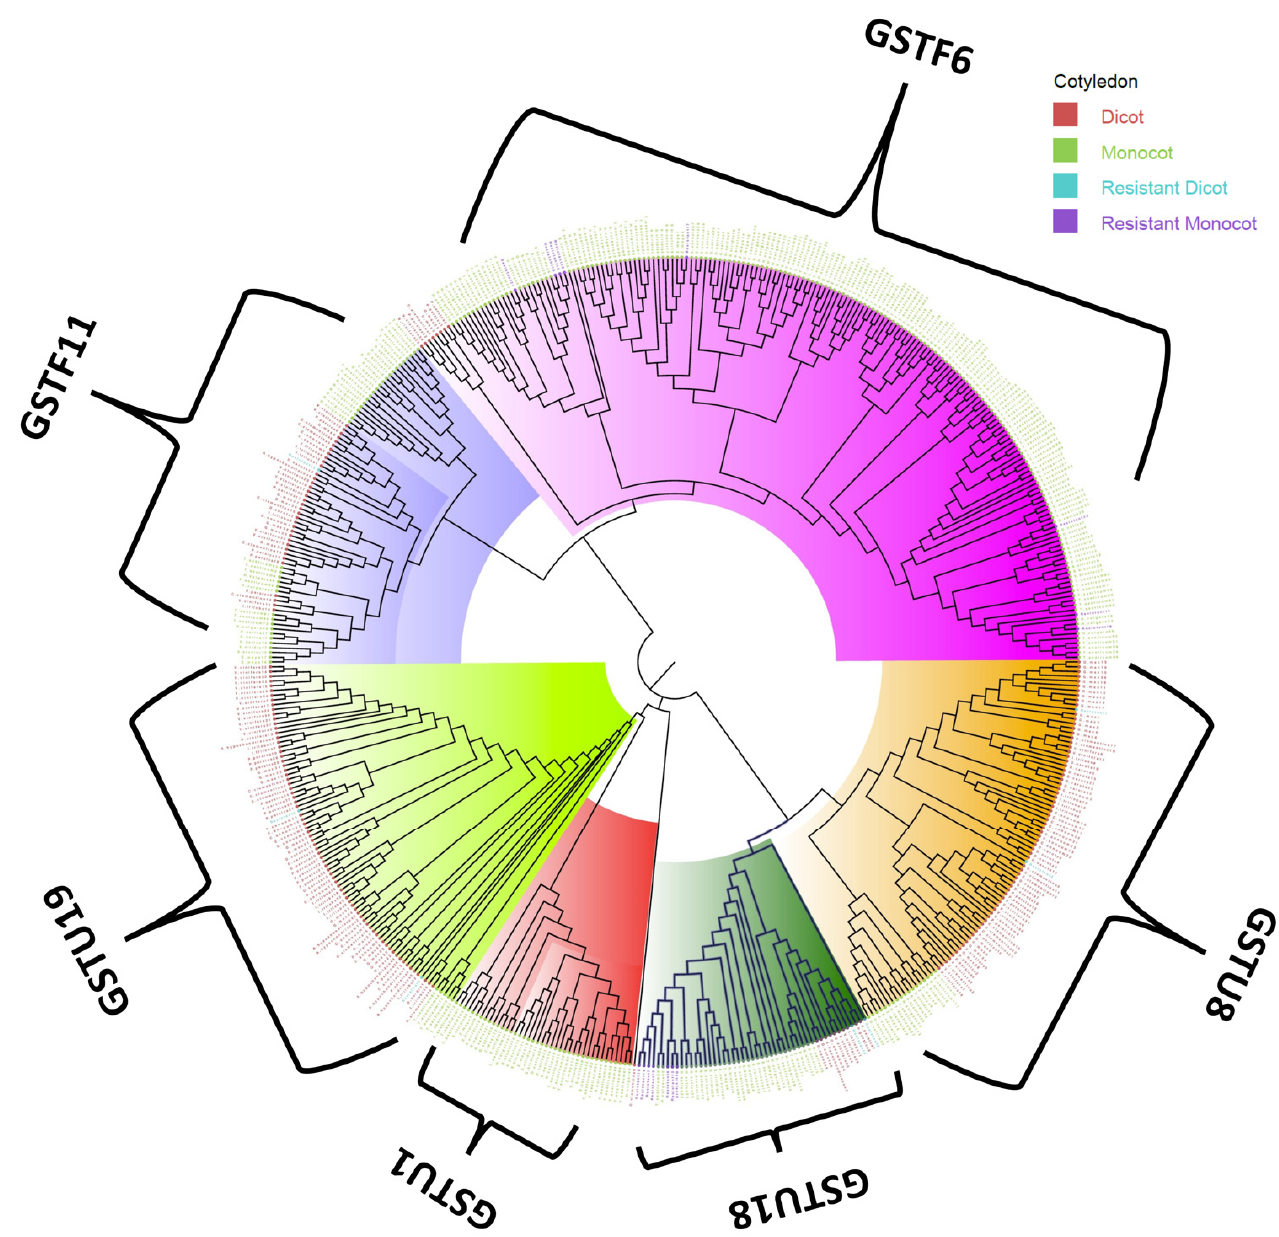
Figure 2. Phylogenetic tree of gene GST . The tree was constructed using the maximum likelihood statistical technique with 1000 bootstrap repetitions. The letters in red, green, violet, and blue legend represents dicot, monocot, GST resistant monocot, and GST resistant dicot. The scale bar for evolutionary distance is 3.0. Major clades are highlighted with colors: GSTU19 (light green), GSTF11 (light blue), GSTF6 (pink), GSTU8 (orange), GSTU18 (dark green), and GSTU1 (red).